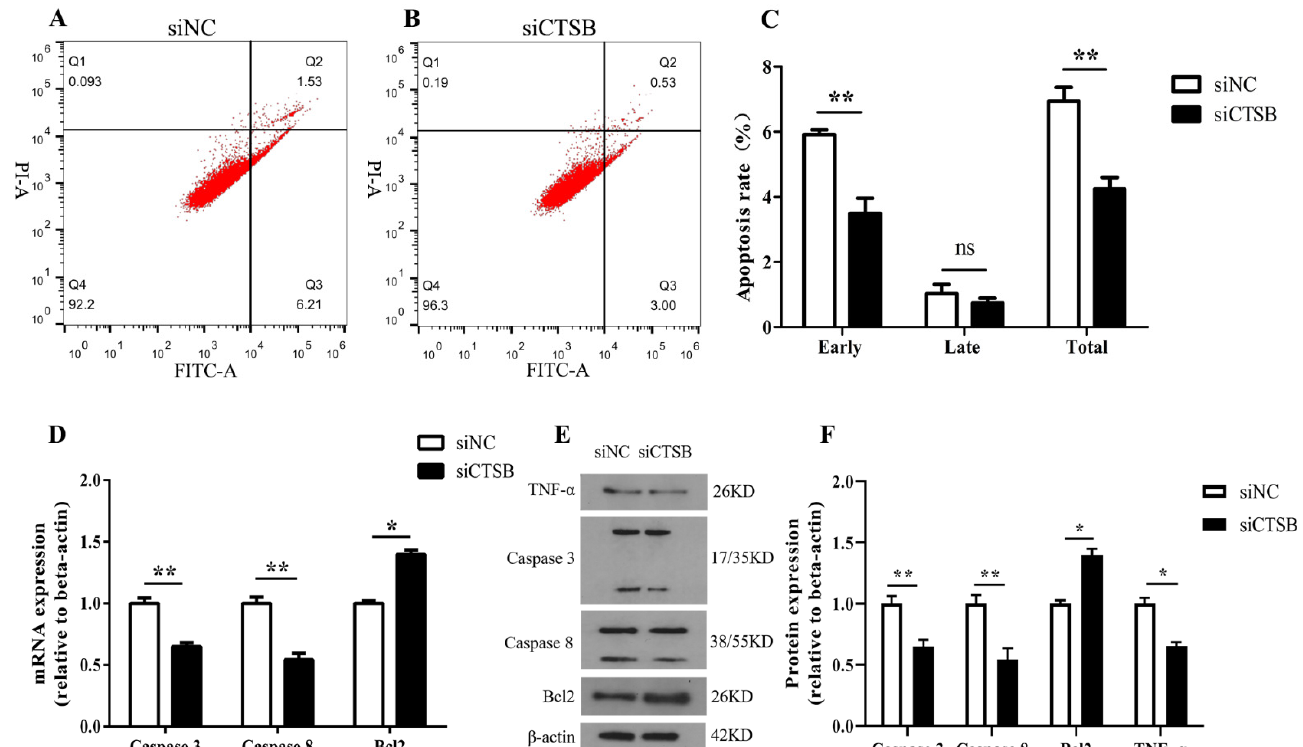
Figure 2. In vitro, CTSB KD inhibits apoptosis and suppresses the expression of apoptosis regulators in mouse GC. ( A ) (siNC) and ( B ) (siCTSB). Flow cytometry analysis was performed to detect dead cells in control and transfected cells (5 × 10 5 cells per 6-well plate) using the annexin V-APC stain. ( C ) The rates of early, late, and total apoptosis were assessed. ( D ) In GCs transfected with siCTSB, the expression levels of apoptosis marker genes caspase 3 , caspase 8 , and Bcl-2 were measured using RT-qPCR. ( E and F ). The expression levels of apoptosis marker genes ( caspase 3 , caspase 8 , Bcl-2 , and TNF ) in siCTSB and NC-transfected GCs were determined using Western blotting against β -actin as an endogenous control. All results, at least from three independent experiments, are presented as means ± SEMs. * p < 0.05, ** p < 0.01. Early apoptosis = lower right (LR); late apoptosis = upper right (UR); viable cells = lower left (LL); necrotic cells = upper left (UL); FITC, v-fluorescein isothiocyanate; PI, propidium iodine; siNC, negative control.